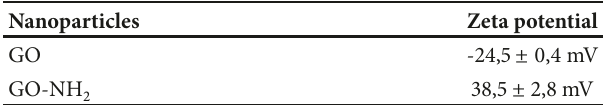
Table 1: Zeta potential of the pristine GO and GO-NH 2 nanoparti-